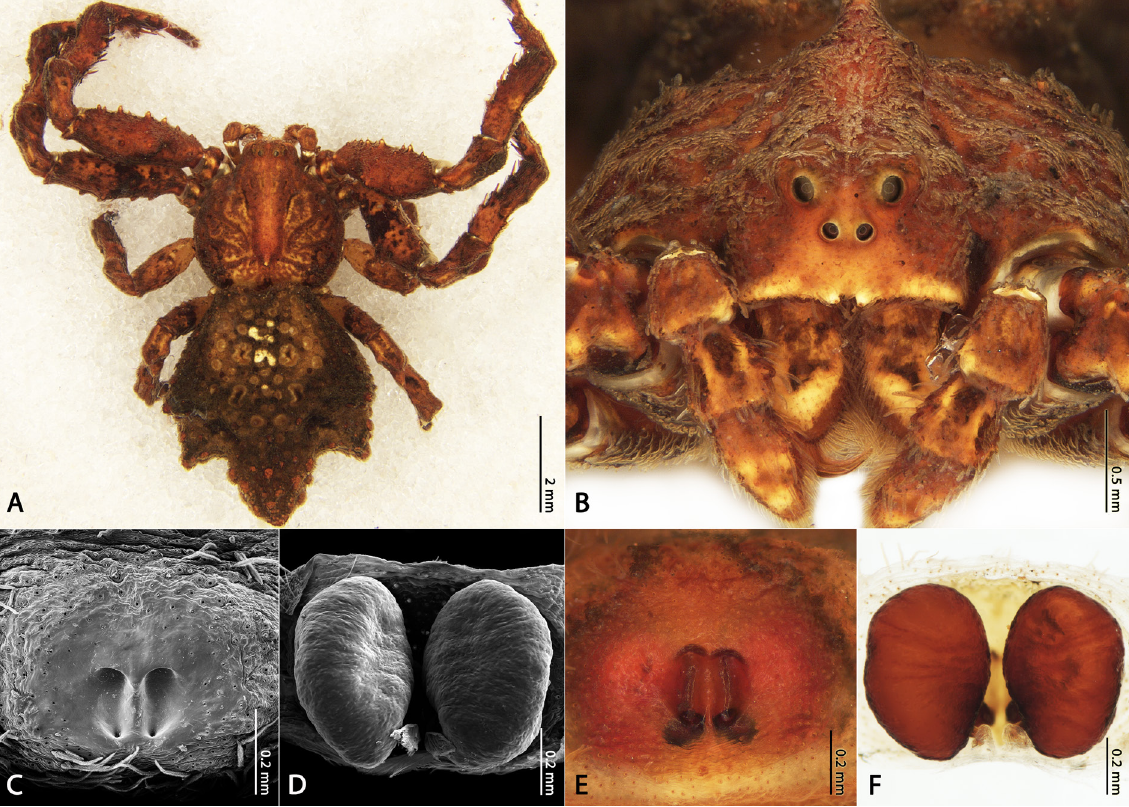
Fig. 10. Female of Kryptochroma pentacantha (Mello-Leitão, 1929) gen. et comb. nov. (MCTP 38671) A . Habitus, dorsal view. B . Front. C, E . Epigynal plate, ventral view, D, F . Spermathecae, dorsal